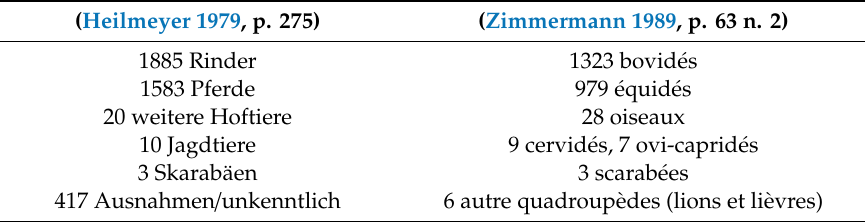
Table 1. Identification of the animal species among the bronze figurines found at Olympia.